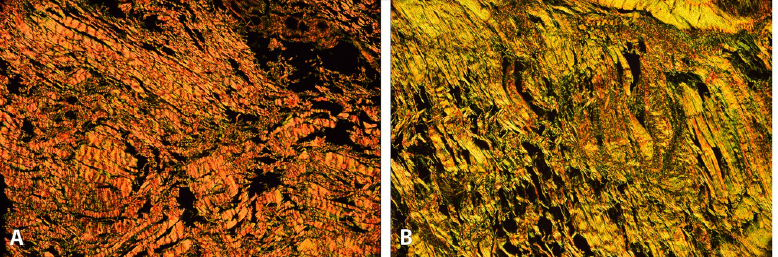
Fig 5. Coracohumeral ligament (CHL). CHL retrieved from shoulders with EIPMT (A) showed a higher number of specimens with predominant type I collagen fibers (orange) compared to normal shoulders (B, predominant collagen type III, yellow-green). (picrosirius-red, original magnification x10, polarized).